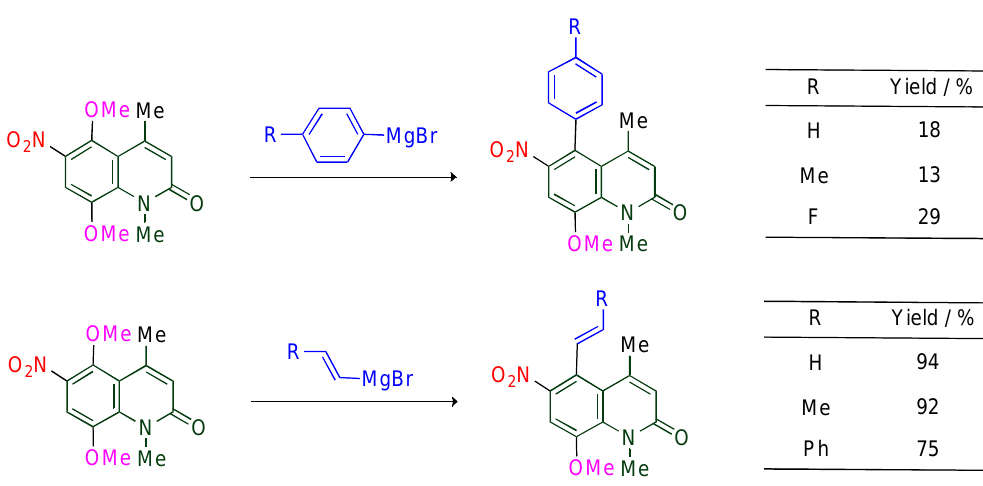
Table 4. Substitution with Grignard reagents.